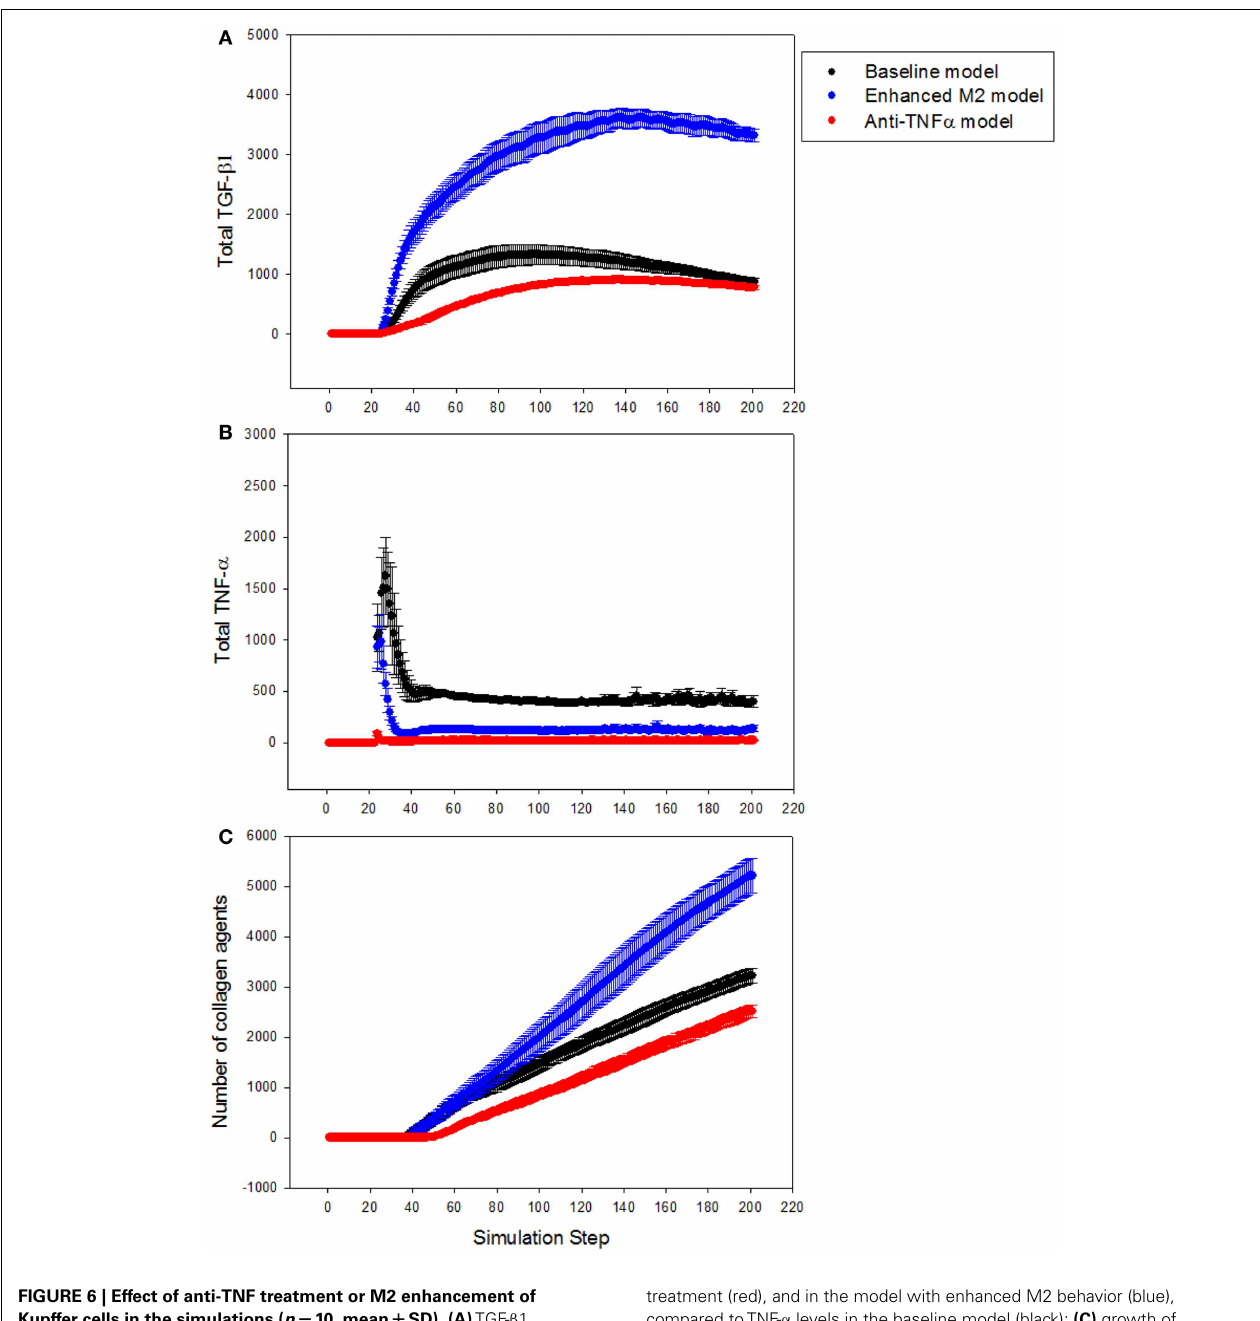
FIGURE 6 | Effect of anti-TNF treatment or M2 enhancement of Kupffer cells in the simulations ( n = 10, mean ± SD) . (A) TGF- β 1 levels in the model with anti-TNF treatment (red), and in the model with enhanced M2 behavior (blue), compared toTGF- β 1 levels in the baseline model (black); (B) TNF- α levels in the model with anti-TNF